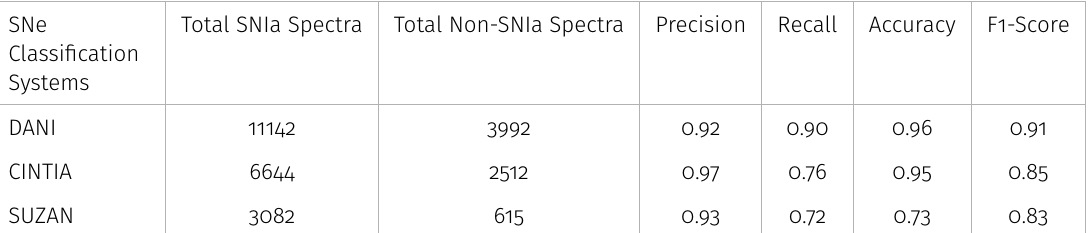
Table II. Benchmark for Supernovae Intelligent Classification Systems.